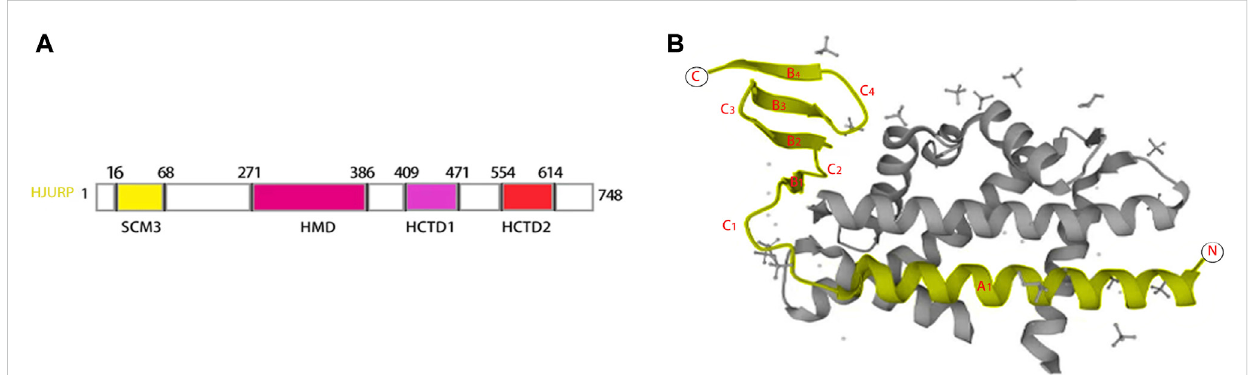
FIGURE 1 Secondary structure and crystal structure of HJURP. The HJURP gene has four secondary structural domains SCM3, HMD, HCTD1, and HCTD2, respectively (A) .The crystal structure of HJURP consists of a long helix (A1) and a triple antiparallel β -sheet connected by a 15-residue ring (C1) (B) .